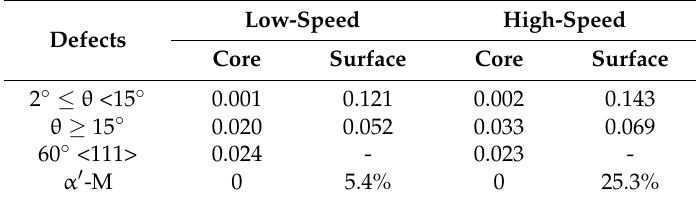
Figure 2. Electron backscattered diffraction (EBSD) results showing phase constitution (PC) map, grain boundary (GB) map, and kernel average misorientation (KAM) map and of the twisted samples at different strained layers. ( a ) and ( b ) are surface and core layers of the sample twisted for 100 cycles at 10 ◦ /min, respectively. ( c ) and ( d ) are core and surface layers of the sample twisted for 100 cycles at 1800 ◦ /min, respectively. Table 1. The length of boundaries per area ( µ m − 1 ) and area percentage of α (cid:48) -M at core and surface layers of low-speed and high-speed twisted samples calculated from electron backscattered diffraction (EBSD) data.